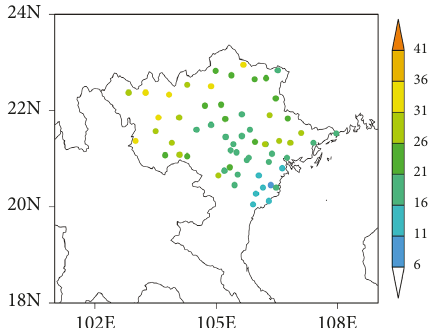
Figure 2: Composite of rainfall value at 95th percentile at Northern Vietnam stations from 1983 to